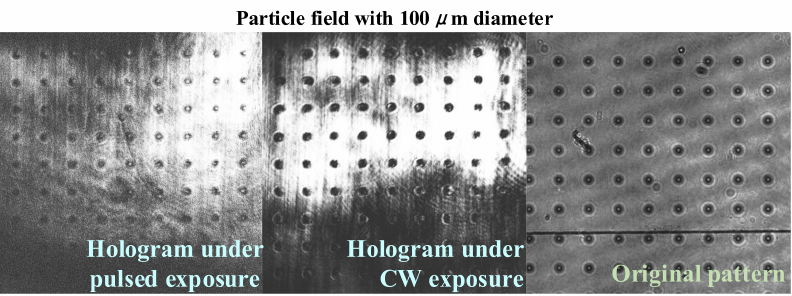
Figure 7. Reconstructed holograms of 100 µ m particle field with pulsed and CW exposure